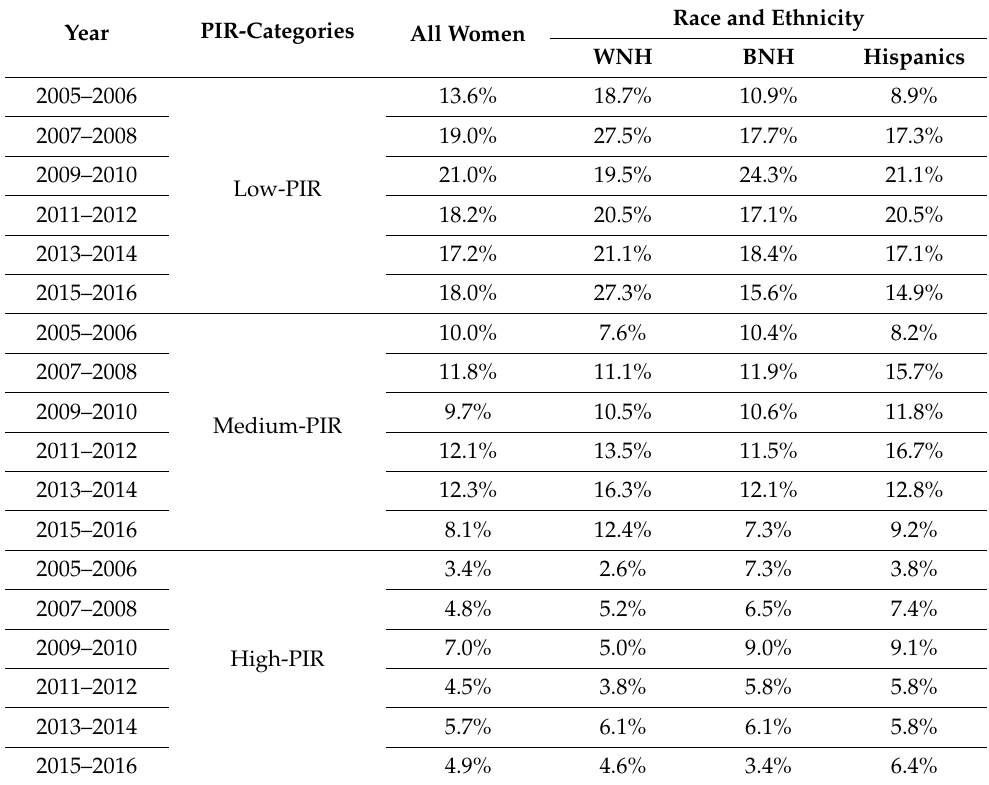
Table A1. Distribution of Clinically Depressed (PHQ scale ≥ 10) Women Among PIR Categories and Race and Ethnicity between